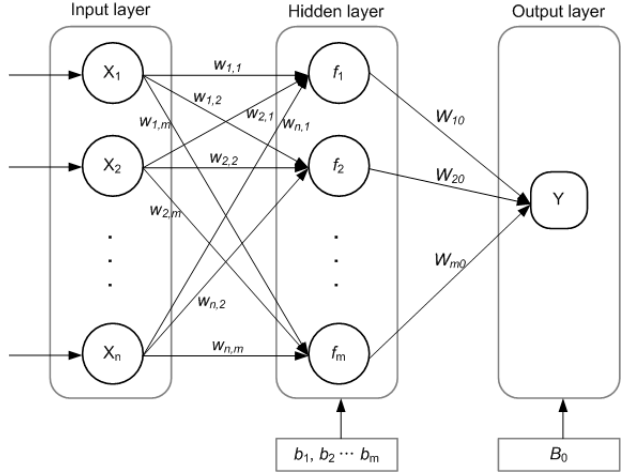
Figure 2. Conceptual diagram of the artificial neural network model.